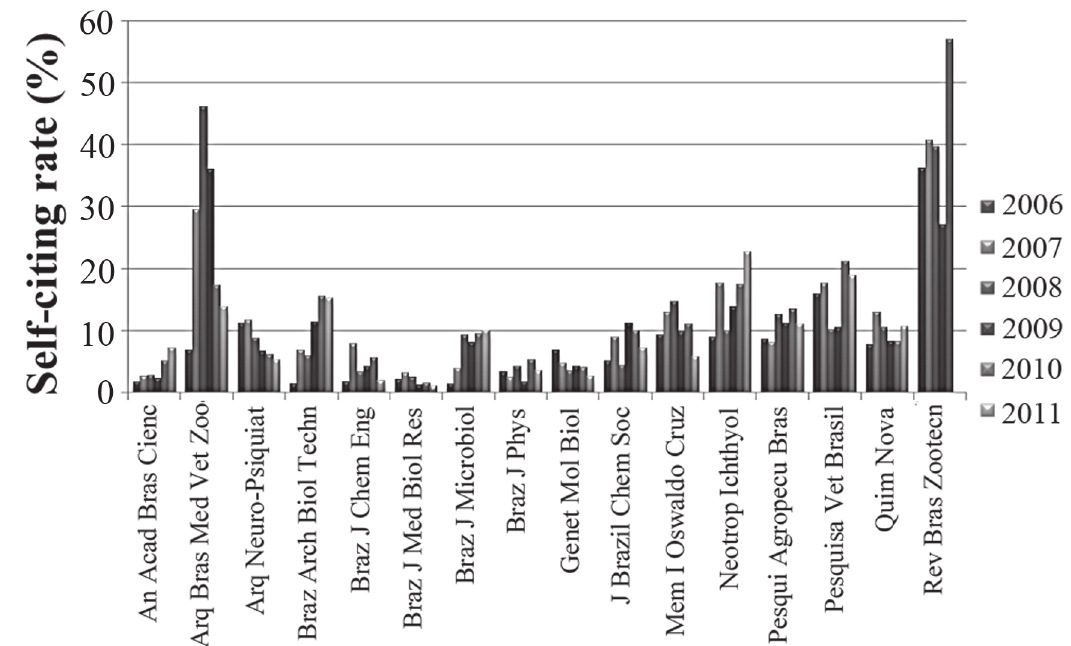
Fig. 2. Brazilian journals and their corresponding self-citing rates between 2006 and Table 5. Percentage of zoology journals in Sample 1 according to self-citing rate intervals.